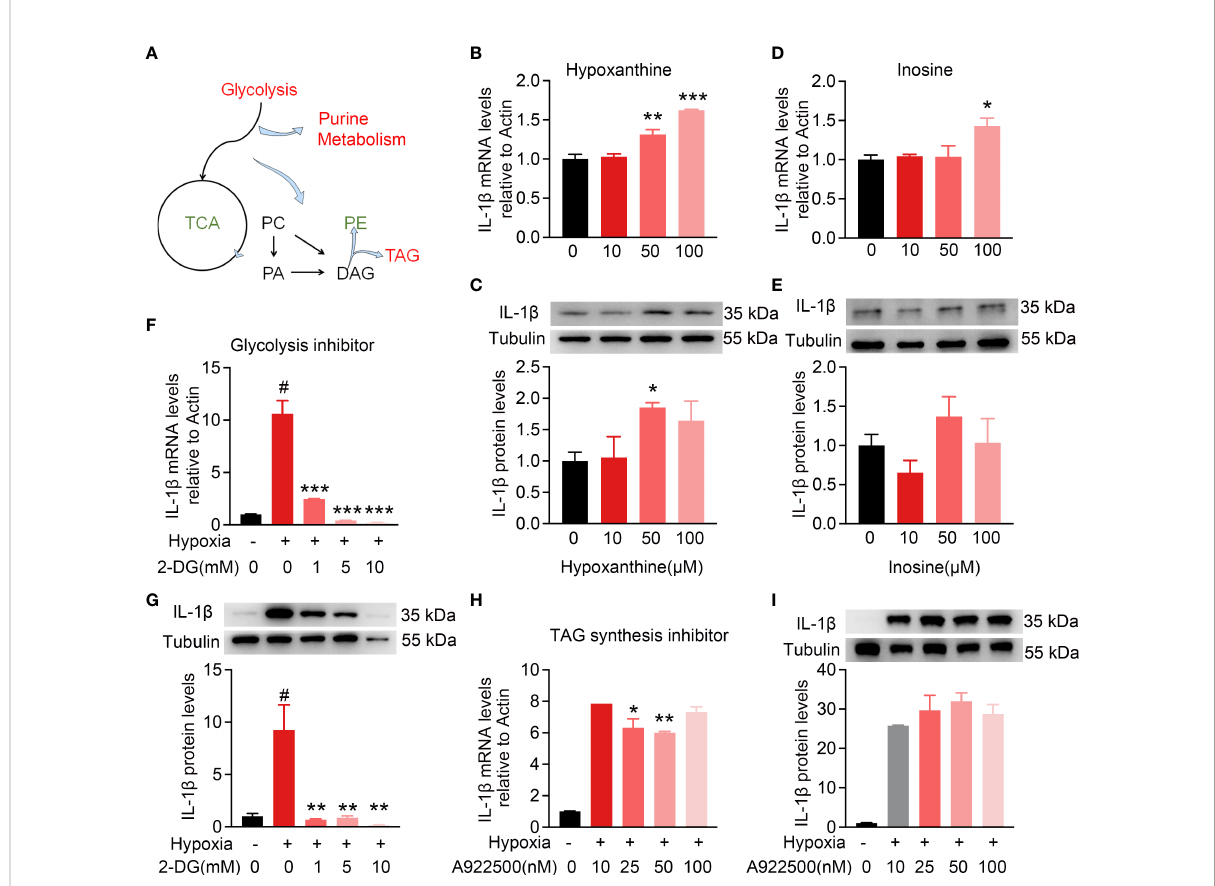
FIGURE 7 Intracellular metabolic microenvironment may regulate IL-1 b expression of microglia. (A) Metabolic working model from metabolomics and lipidomics indicated hypoxia-induced microglia activation with intracellular glycolysis, purine metabolism, and TAG synthesis increase and TCA deceleration. (B – E) Purine metabolism intermediates hypoxanthine (10, 50, and 100 m M) and inosine (10, 50, and 100 m M) induced IL-1 b expression in BV2 cells at different levels. (F,G) Hypoxia-induced IL-1 b expression at RNA and protein level with or without glycolysis inhibitor 2- DG (1, 5, and 10 mM), respectively, using RT-PCR and Western blot. n = 3 for each group. *p < 0.05, **p < 0.01, and ***p < 0.001. (H,I) Hypoxia- induced IL-1 b expression at RNA and protein levels with or without TAG synthesis inhibitor A922500 (10, 25, and 100 nM) using RT-PCR and Western blot. The meaning of # symbol is “ no statistical difference ”